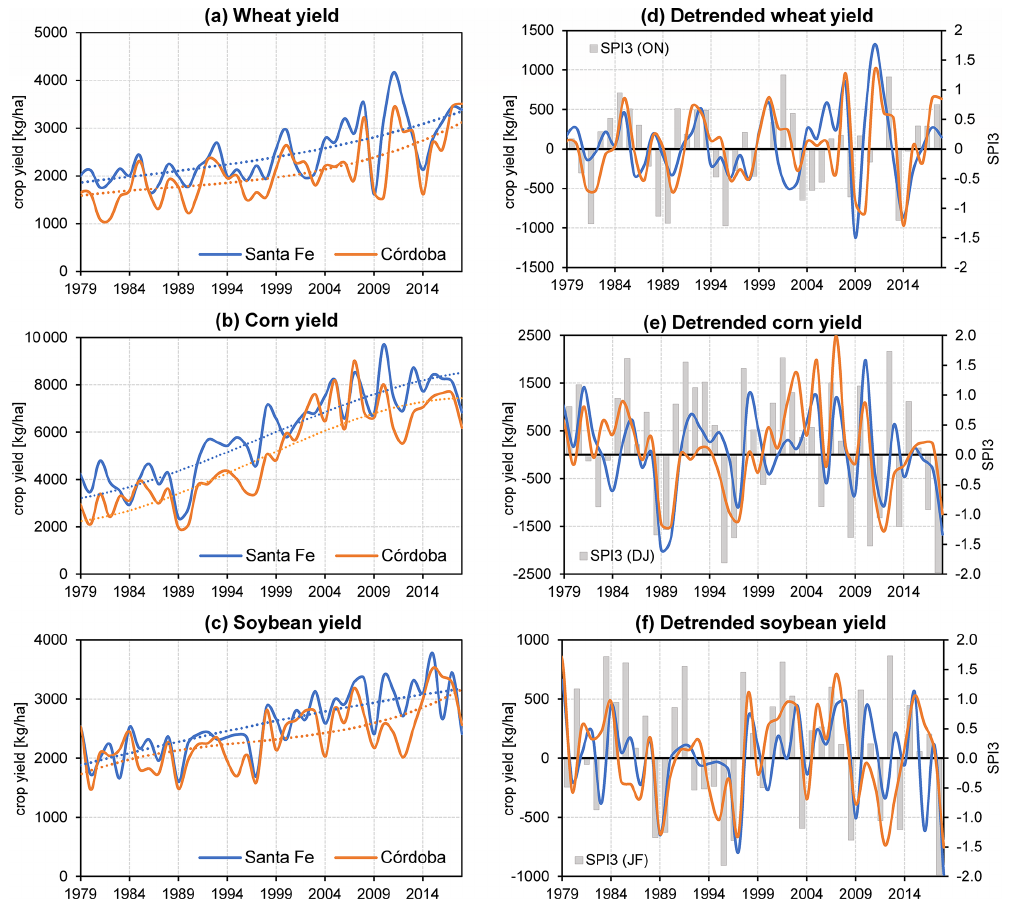
Figure 8. The time series of the area-averaged annual crop yield over the provinces of Santa Fe and Córdoba from 1979 to 2018. (a) Wheat, (b) corn, and (c) soybean yields. Cubic polynomial trends are shown as dotted lines. Panels (d) – (f) show the detrended yields for Santa Fe (blue) and Cordoba (orange). The superimposed gray bars characterize the SPI3 values corresponding to the crops’ critical growing months, including ON for wheat, DJ for corn, and JF for